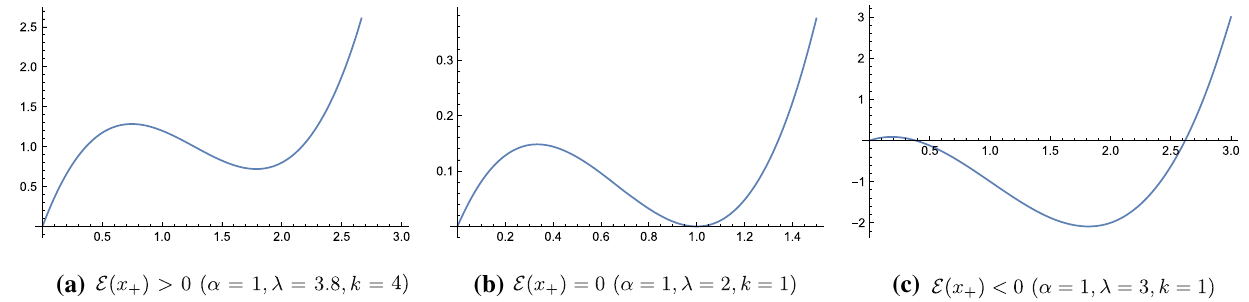
tivevacuumenergiesareshown.Examplesoftheparametersthatsatisfy the conditions in the main body of the text are